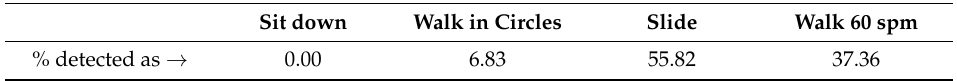
Table 3. Percentage of false